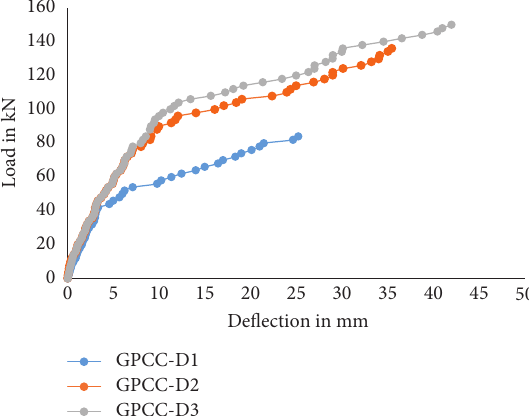
Figure 12: Load-deflection behaviour of GPCSC (DRB).